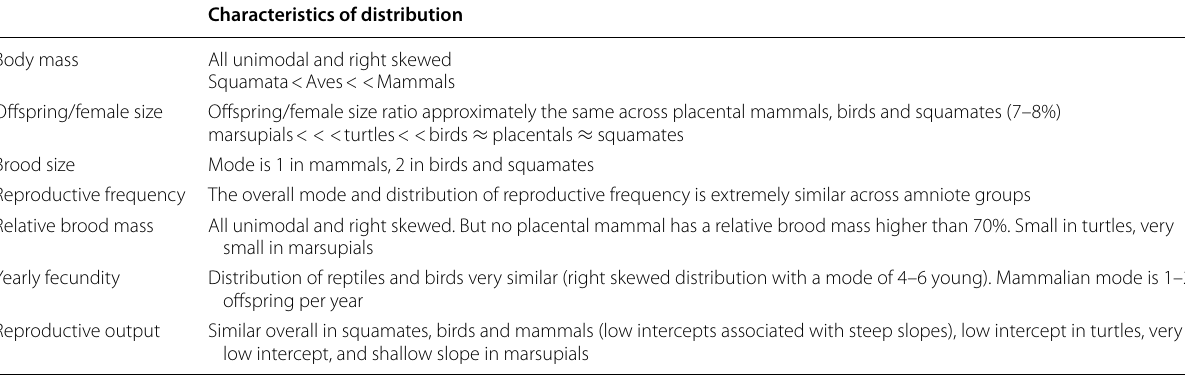
Table 2 Summary table comparing life history distribution across amniotes Characteristics of distribution Body